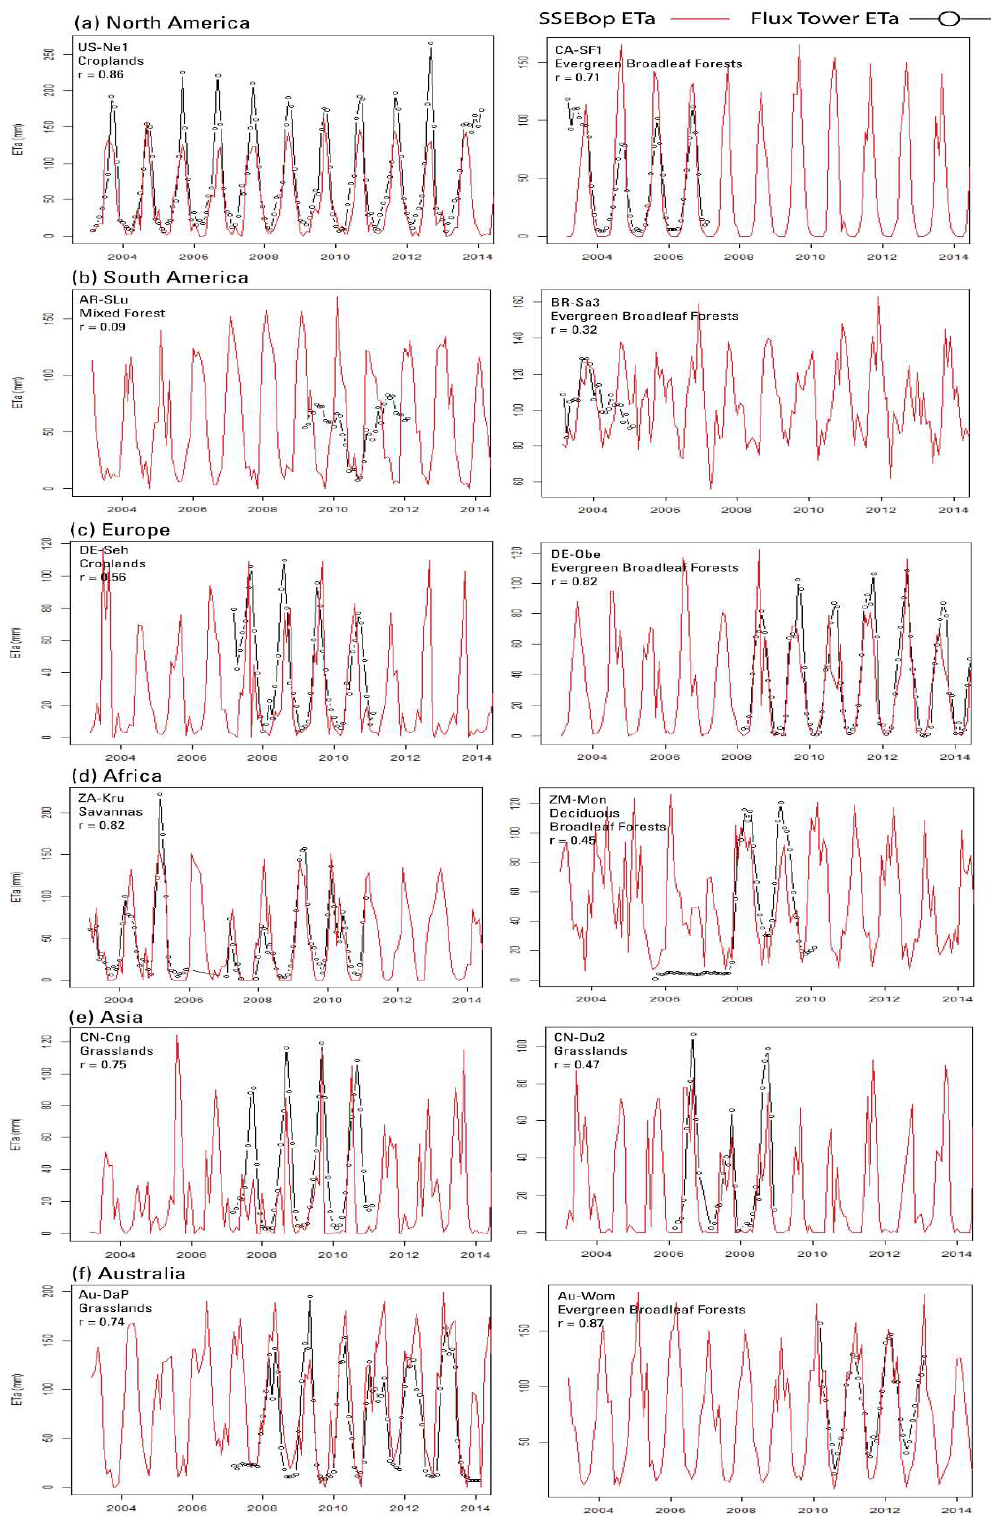
Figure 4. Monthly traces of SSEBop (red) and observed (black) EC flux tower ETa (mm) organized by continent. Two EC towers are shown for each of the six continents. SSEBop is shown from the start (2003) until the most recent available EC date (2014) for visual inspection of year-to-year variability. Land cover type and r values are shown for the flux tower sites.